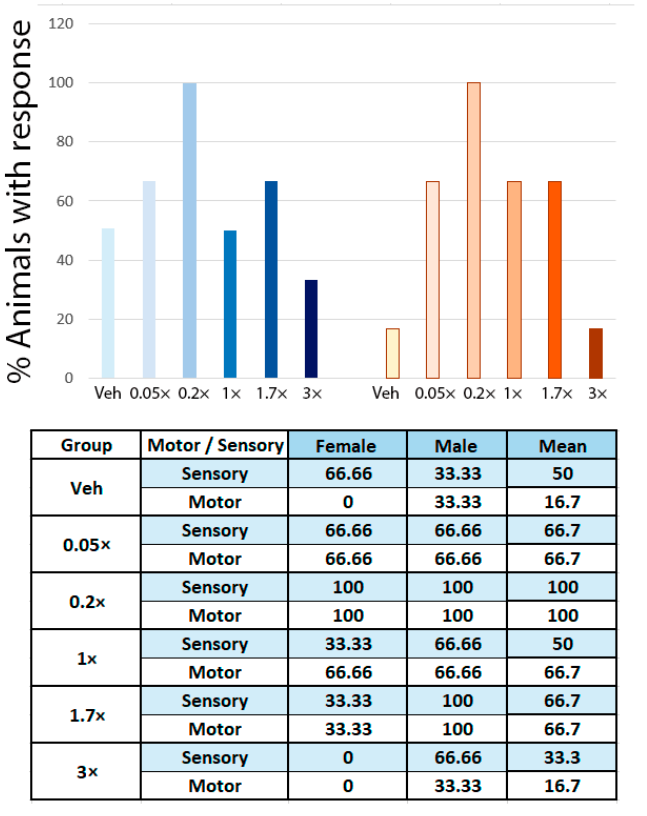
Figure 2. Graph and table showing the percentage of animals with sensory (Von Frey test) or motor reinnervation (compound muscle action potential (CMAP) response at plantar interossei) at 25 days post crush in different experimental groups. Table 1. Mean amplitudes ( ± SEM) values of CMAP recordings obtained during follow-up post-crush fromGastrocnemius(Top), andplantarinterosseimuscles(Bottom)inVeh-orNeuroHeal-treatedanimals (NH = NeuroHeal). ( n = 5 for CTL, 6 for other groups, ANOVA, post hoc Bonferroni, * p < 0.05 vs.